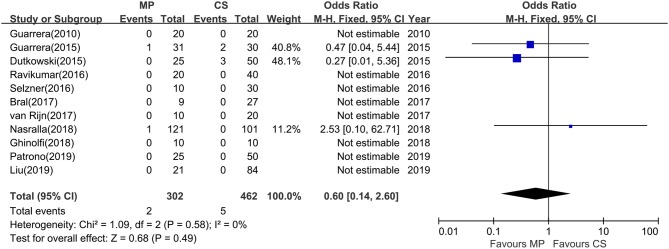
Meta-analysis on PNF rates between MP and CS preservation. MP cannot reduce the PNF rates (OR = 0.60; 95% CI = 0.14–2.60; P = 0.49). Data are expressed as OR ± 95% CI. PNF, primary nonfunction; MP, machine perfusion; CS, cold storage; CI, confidence interval.